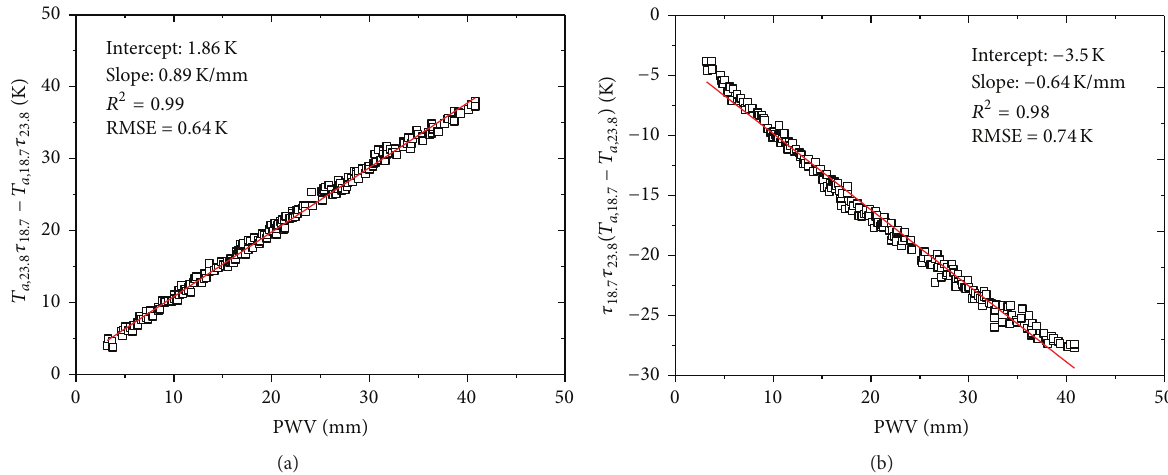
Figure 3: Linear relationships between (a) 𝑇 𝑎,23.8 ⋅ 𝜏 18.7 − 𝑇 𝑎,18.7 ⋅ 𝜏 23.8 and PWV and (b) 𝜏 18.7 ⋅ 𝜏 23.8 (𝑇 𝑎,18.7 − 𝑇 𝑎,23.8 ) and PWV.